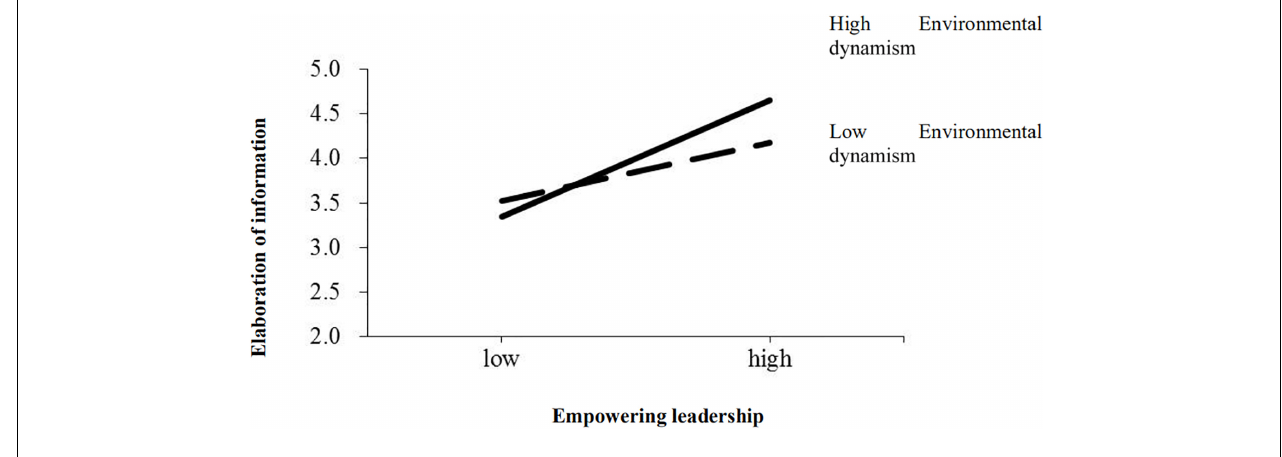
FIGURE 2 | Interaction between empowering leadership and environmental dynamism.